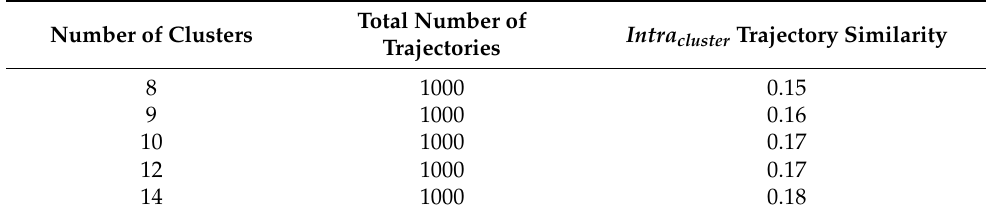
Table 11. k-means clustering